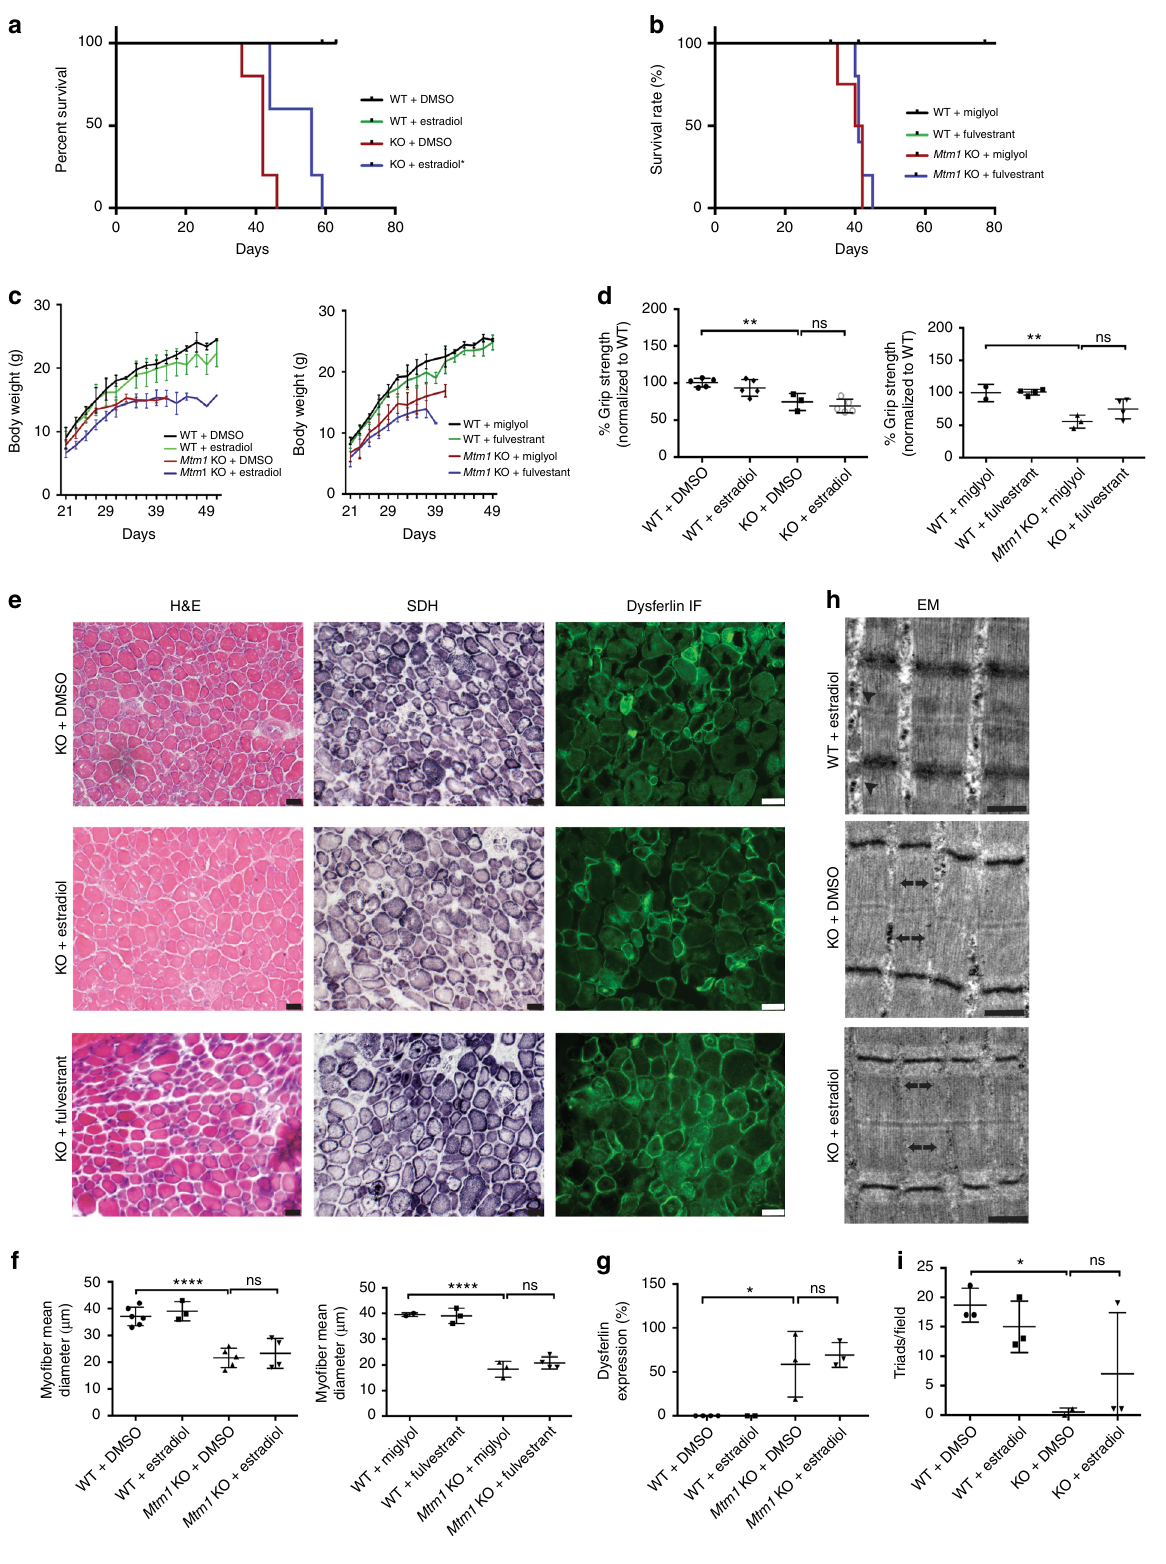
levels of wild-type littermates (Fig. 8c – h). Of note, tamoxifen treatment did not change Dnm2 transcript levels (Supplemen- tary Figure 7), suggesting the effect of tamoxifen on DNM2 is mediated via changes in DNM2 protein translation and/or stability.